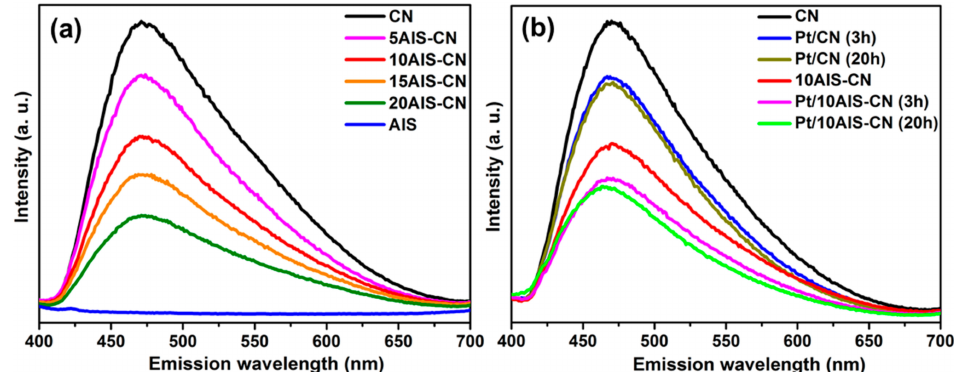
Figure 7. Photoluminescence spectra of as-prepared catalysts without Pt ( a ) and Pt containing catalysts after 3 h and 20 h use under UV-vis irradiation ( b ) For comparison the Pt free supports are shown in plot b as